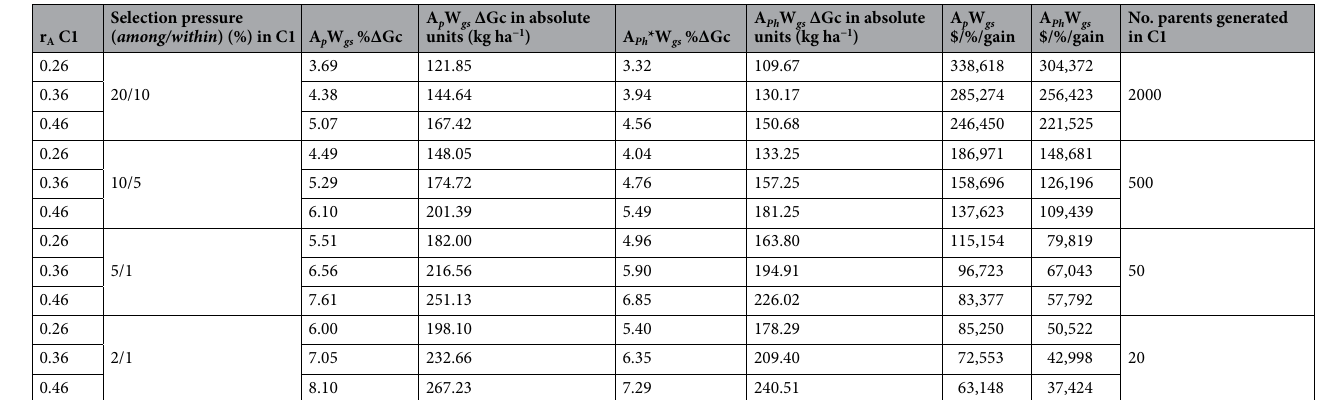
Table 6. Simulation cycle 1 (C1) of selection for seasonal DM yield among 1000 HS families of perennial ryegrass based on among family phenotypic selection, using data from a field trial conducted across 2 locations, 2 years with 3 seasonal measurements per year. Genomic selection (GS) was applied to individuals within the selected HS families. Combinations of among and within ( among/within ) HS family selection at different selection pressures (%) and different genomic prediction accuracies (r A ) were applied. The costs per percent genetic gain, relative to the mean BLUP value (3301 kg ha -1 ), of the 1000 HS families, based on DM cuts and phenomics ( Ph ) were $7.50 and $0.87 per sample, respectively. For GS, $41 was used as the cost for generating a single GEBV (genomic estimated breeding value). A cycle of selection is the number of years of the field trial (2 years) plus one extra for progeny generation, total 3 years. Percentage genetic gain per cycle of selection (%ΔGc), cost per percentage of predicted genetic gain ($ per % gain), among Ap family phenotypic selection and within HS gs family genomic selection (A p W gs ) and Ph selection (A Ph W gs ). r A, is the Pearson correlation coefficient between Phenotypic Estimated Breeding Values and Genomic Estimated Breeding Values. $, New Zealand dollars. These results are based on the estimated variance components from REML analysis, used as starting points for simulation of breeding methods. Ph *, LiDAR based phenomics accuracy = 0.90.